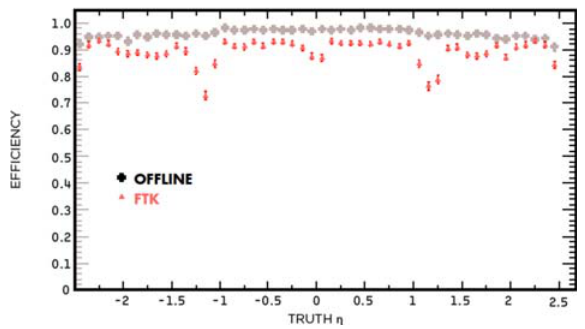
Figure 4. Comparison of o ffl ine reconstructed single particle track e ffi ciency with those reconstructed in FTK as a function of the track rapidity[7].